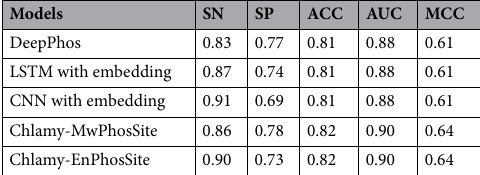
Table 8. Performance metrics of different models using an independent test dataset for S and